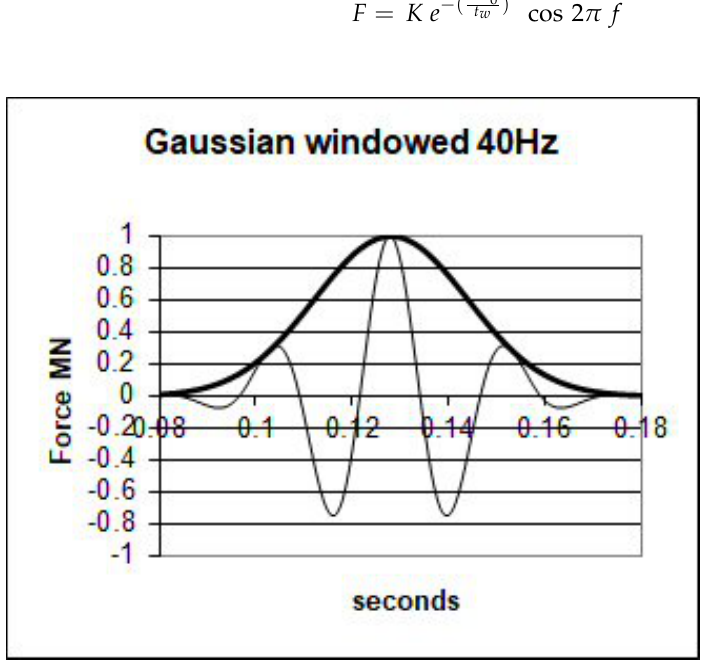
Figure 2. An example of a time profile used in recent FE work. The envelope form is shown in Figure 2 by the bold black line, while the applied force is shown by the lighter grey line. This improved impulse driver allowed the frequency of the propagated displacement wave to be set. However, it was not based on any measurements of piling action, but rather adopted to replicate features of the observed waveforms.